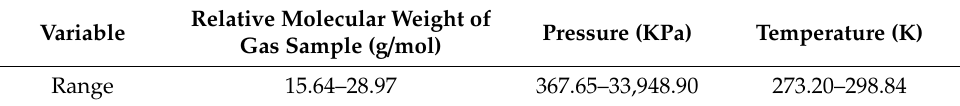
Table 1. Variable ranges of the genetic algorithm–support vector machine (GA-SVM) model.